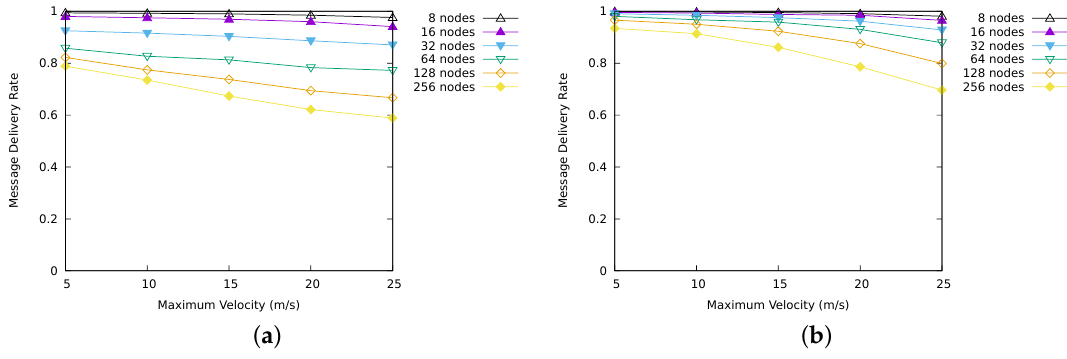
Figure 6. Message delivery rate for LBR1 and LBR2. Results for a generation rate of 10 messages per node and second. ( a ) LBR1 message delivery rate; ( b ) LBR2 message delivery